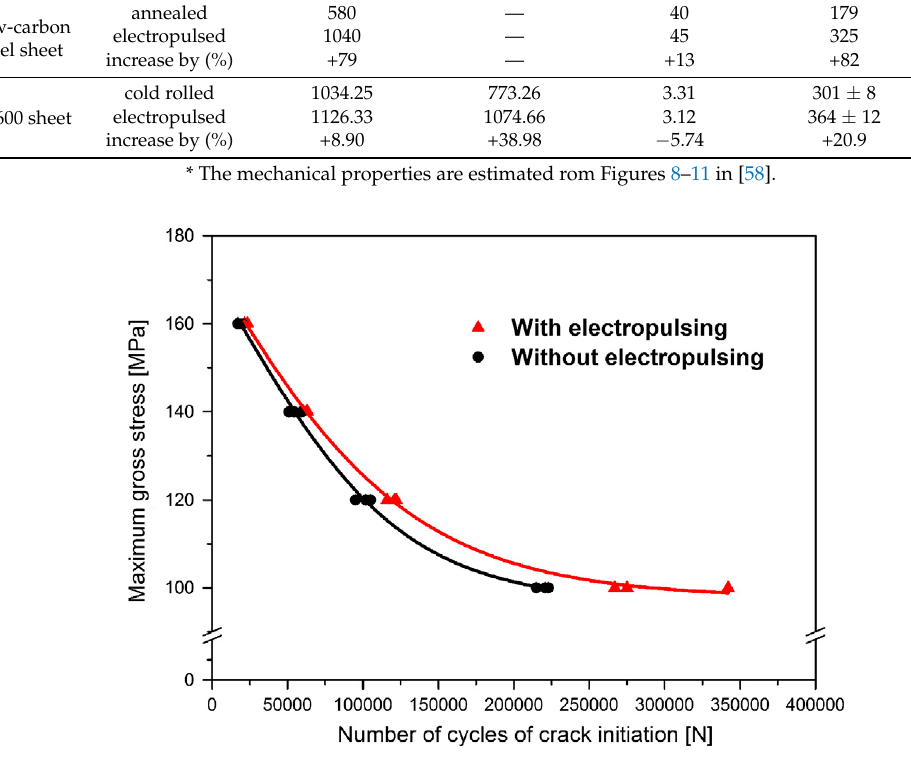
Figure 8. S-N curves of stainless steel (SUS316) before and after EPT [116].